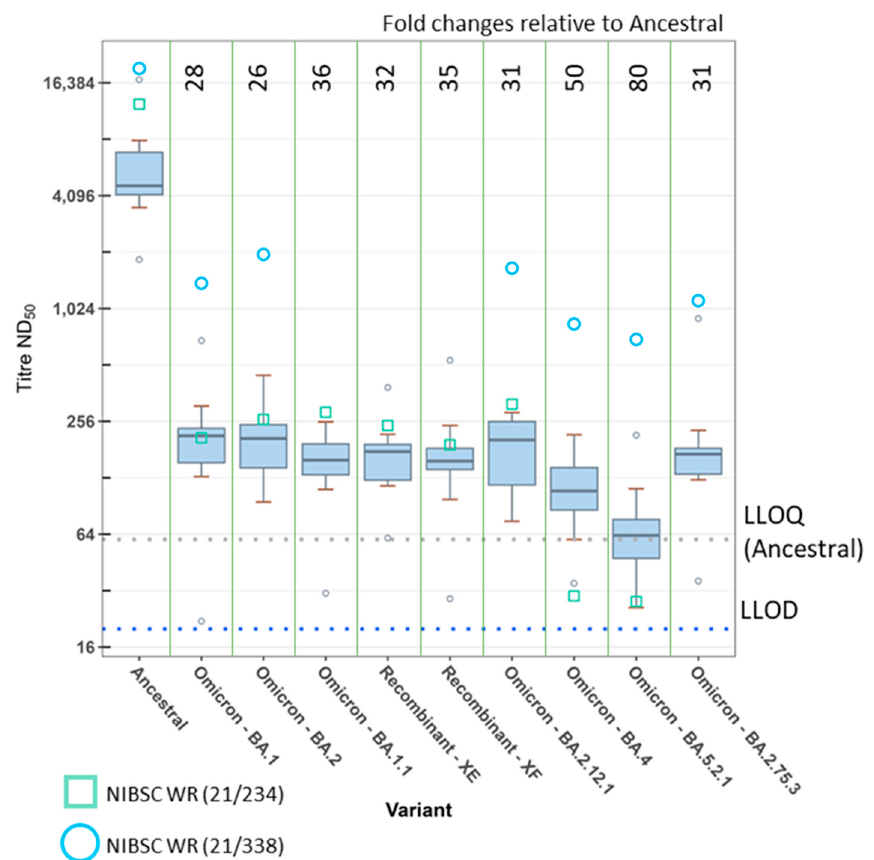
Figure 2. Neutralising antibody titres of a panel of triple-vaccinated human participant sera deter- mined with FRNT against authentic SARS-CoV-2 variants. A panel of 10 sera from triple-vaccinated human volunteers was assessed at UKHSA with FRNT over a dilution range of 1/20 to 1/40,960 with 10 authentic SARS-CoV-2 variants. Data are presented as median and interquartile ranges of titre ND 50 . Fold changes relative to the ancestral virus were calculated with regression analysis using a linear mixed-effect model and are presented where the difference is significant (two-way ANOVA with Tukey’s post hoc test). The lower limit of detection (LLOD) of 1/20 is indicated by the blue dotted line. The lower limit of quantification (LLOQ) of 1/58, as determined for the ancestral assay, is indicated by the grey dotted line. Neutralisation titres of the NIBSC WR 21/234 and 21/338 are presented as a green box and a blue circle, respectively.